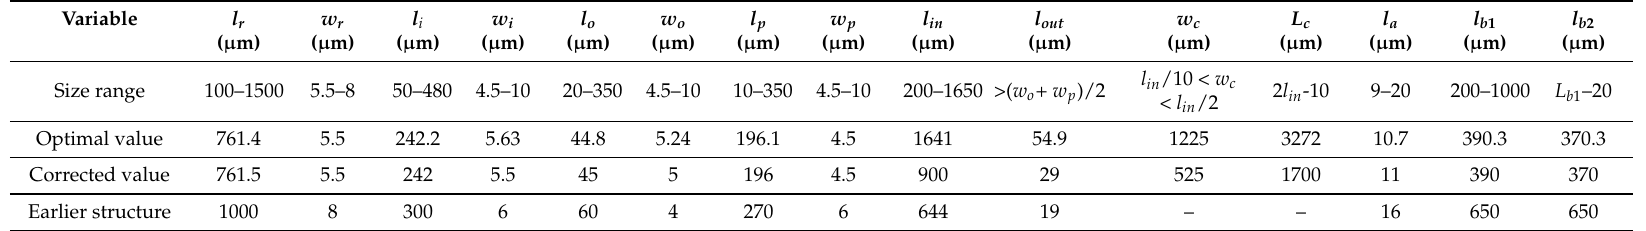
Table 1. Sensitive Structure Dimensions of the SMRA compared to earlier